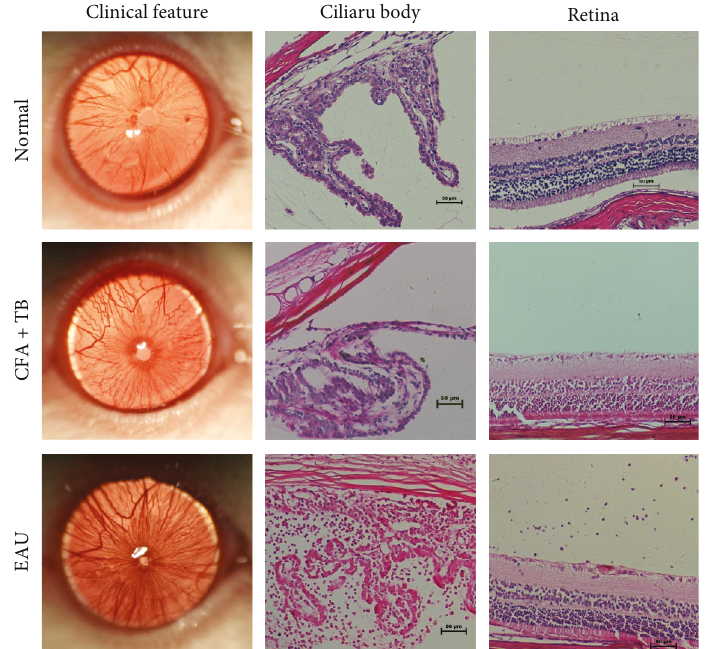
Figure 1: Clinical and histopathological characterizations of rat eyes and tissues from normal and EAU individuals on day 12 postimmunization. Retinal images were captured with a handheld retinal camera, and hematoxylin and eosin staining was performed on eye sections. Bar=50 μ m.